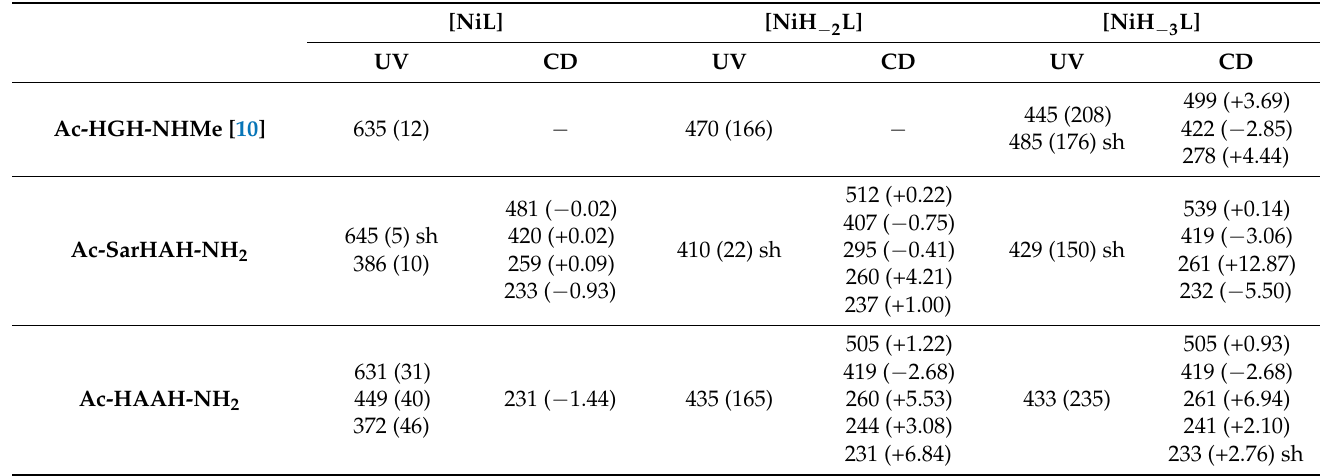
Table A4. Visible and CD spectral parameters of the nickel(II)